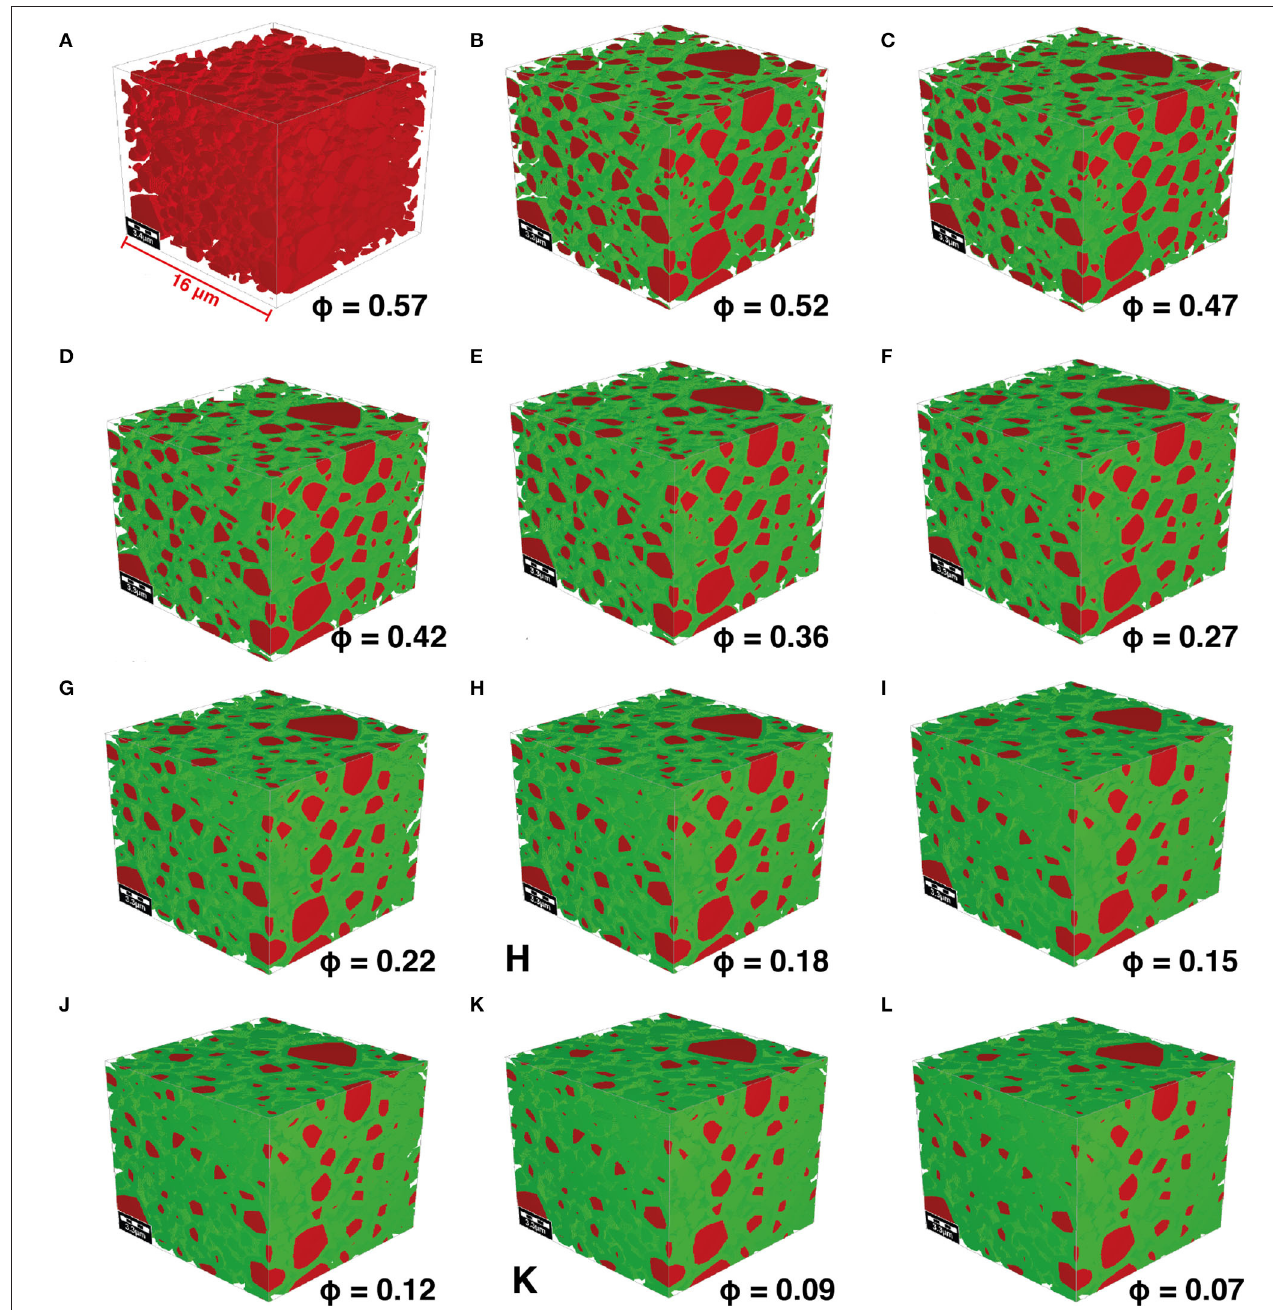
pore networks was constructed using object-based techniques (Andrew, 2020). The connected micritic matrix was separated into a network of discrete, separated micrite grains using a watershed algorithm ( Figure 3E ). The